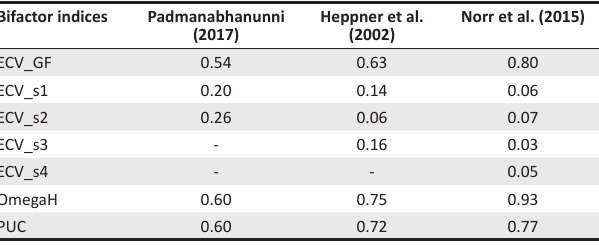
TABLE 1 : Bifactor indices for three